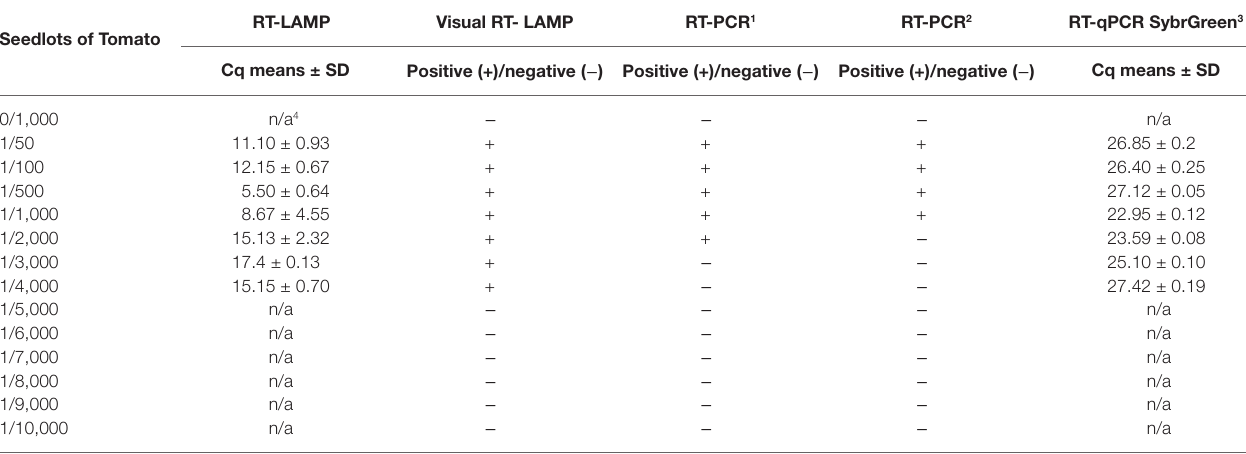
Seedlots of Tomato